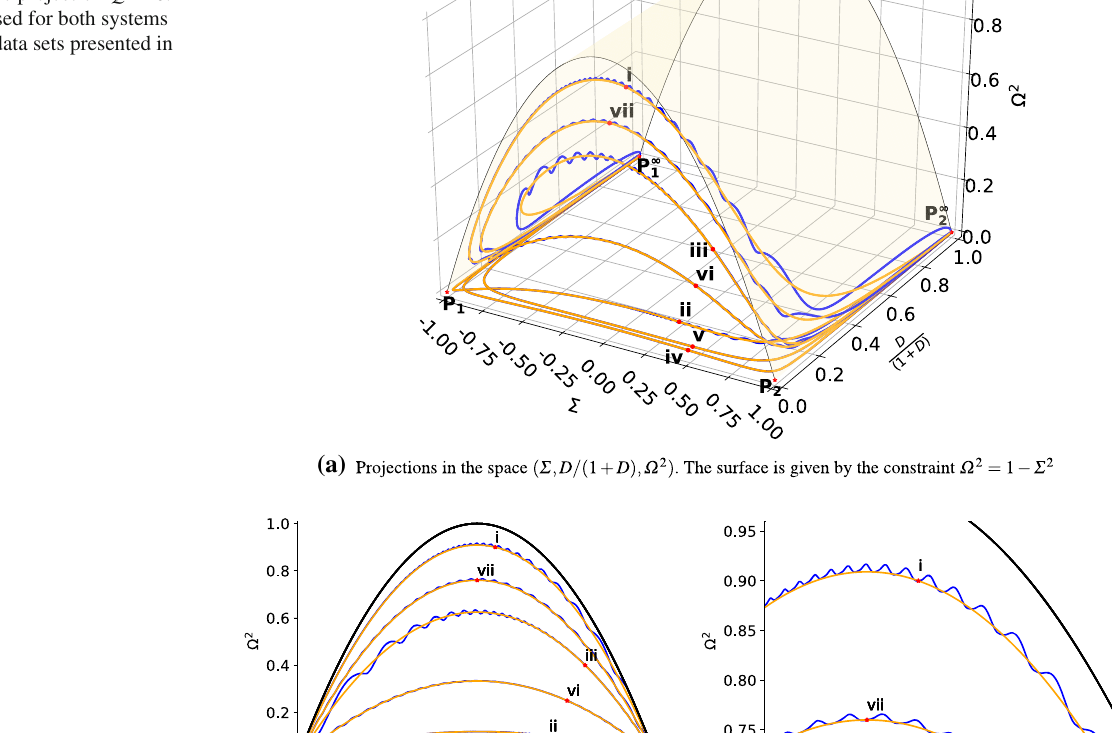
Fig. 15 Some solutions of the full system (93) (blue) and time-averaged system (127) (orange) for the KS metric when γ = 1 in the projection Q =